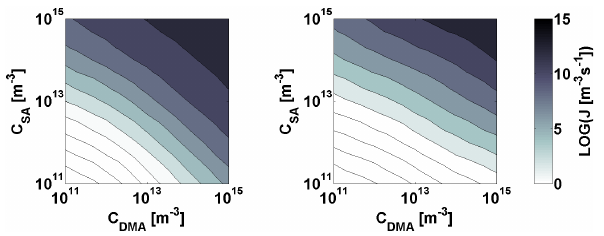
Fig. 3. The particle formation rate as a function of dimethylamine monomer and sulfuric acid monomer concentrations. The right plot considers only monomer evaporations and cluster collisions, while the left plot allows all evaporations and collisions. The colour scale is shown on the right, and gives the base-10 logarithm of the particle formation rate defined in the text.